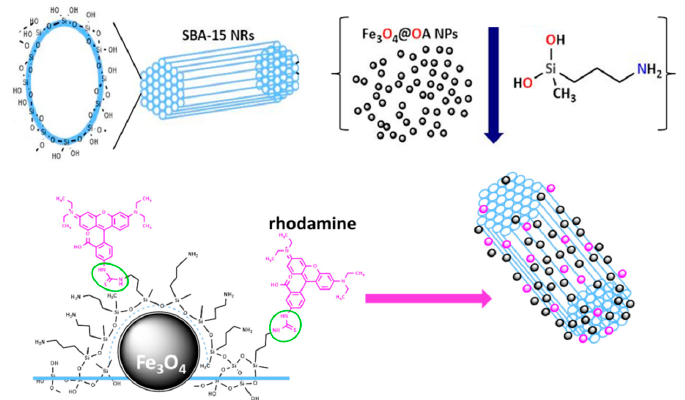
Figure 1. Scheme of the ordered mesoporous silica ceramic with Si–OH groups exposed on the surface (top). Anchoring of magnetite nanoparticles by adding functional ethoxysilane molecules allows the formation of the HMMSN hybrid mesoporous magnetic nanorods. Fluorescent dye (rhodamine) is further attached on top.